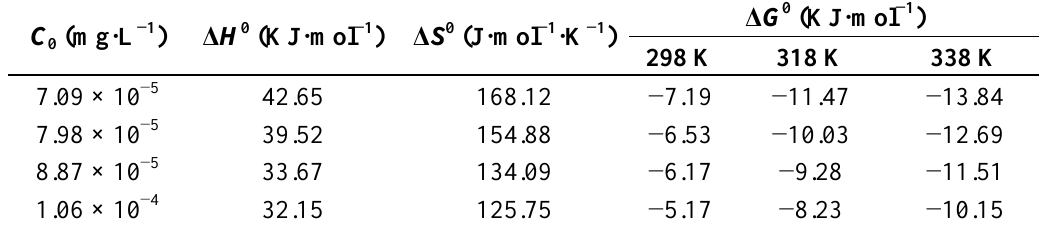
Table 2. Values of thermodynamic parameters for the adsorption of Th(IV) on